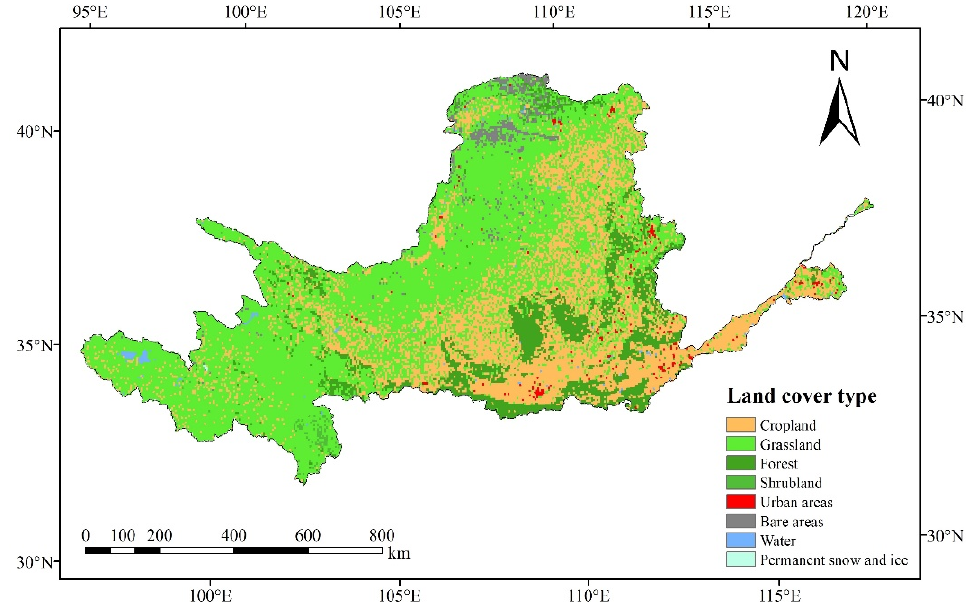
Figure 2. Different vegetation types in the Yellow River Basin.